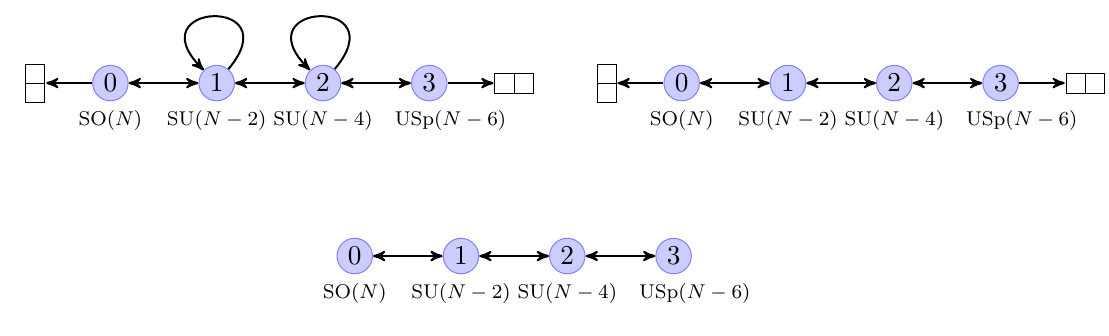
Figure 11. The chain of linear quiver diagrams after the orientifold connected by mass deformation for n = 6 : C 2 / Z 6 × C → L 2 , 4 , 2 → L 3 , 3 , 3